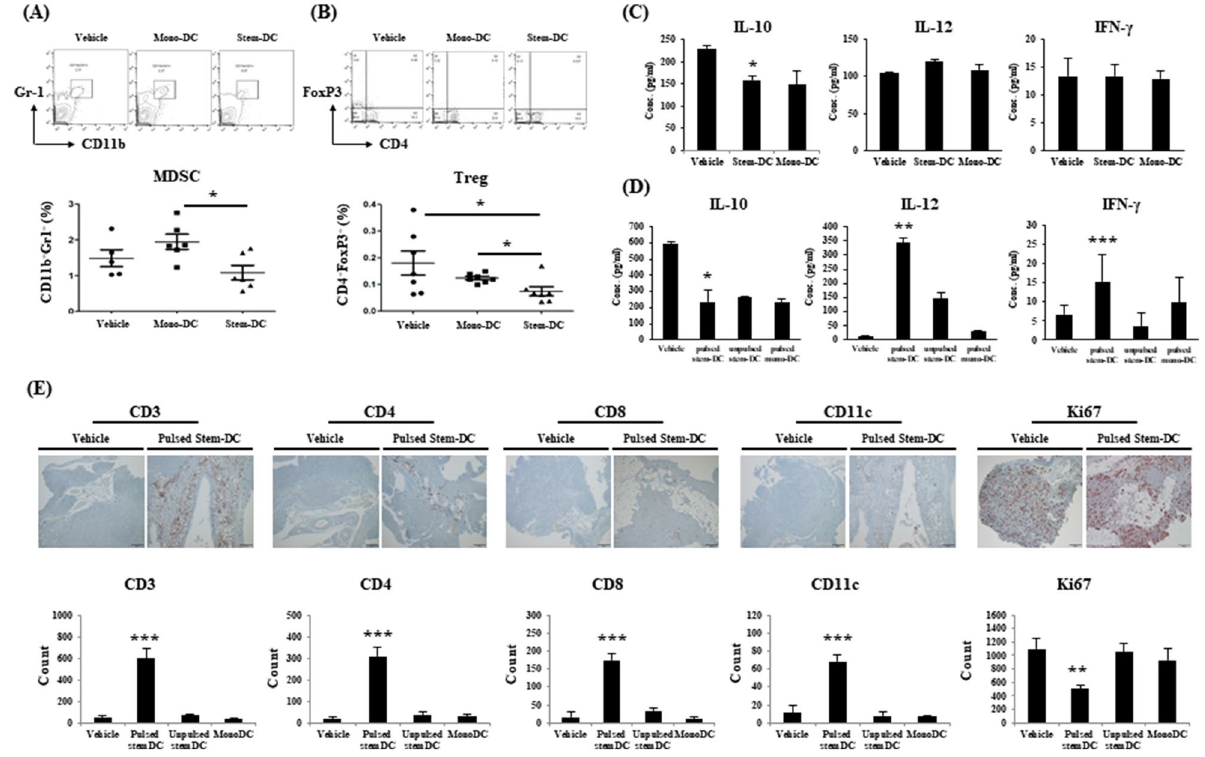
Figure 6. Immune responses in blood samples, ascites, and tumor tissues after DC treatments. We investigated immune reactions after DC treatments in the vehicle, Stem-DC (high dose), and Mono-DC groups. ( A ) In the FACS analysis, the proportion of MDSCs was lower in the serum of the pulsed Stem-DC group than in the serum of the Mono-DC group (P = 0.0141). ( B ) Similarly, in the FACS analysis, the proportion of regulatory T cells (Tregs) was significantly lower in the pulsed Stem-DC group than in the vehicle and Mono-DC groups (P = 0.0434 and P = 0.0132, respectively). ( C ) When we investigated the secretion of three cytokines